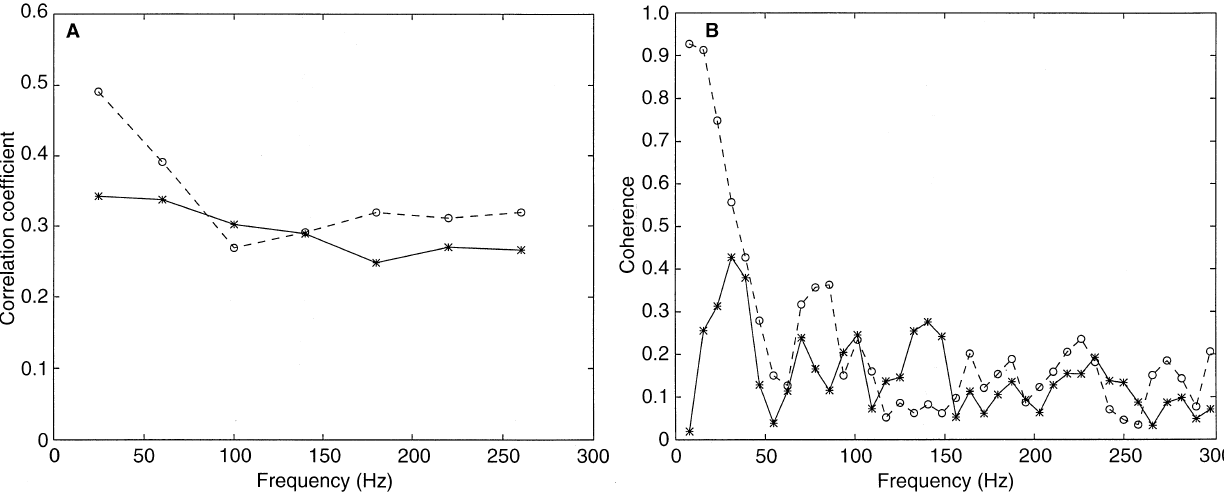
by analyzing the same data in terms of the cross-power spectrum normalized by the square root of the product of the corresponding